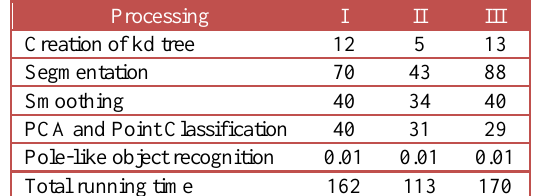
Table 3. Running time of our method